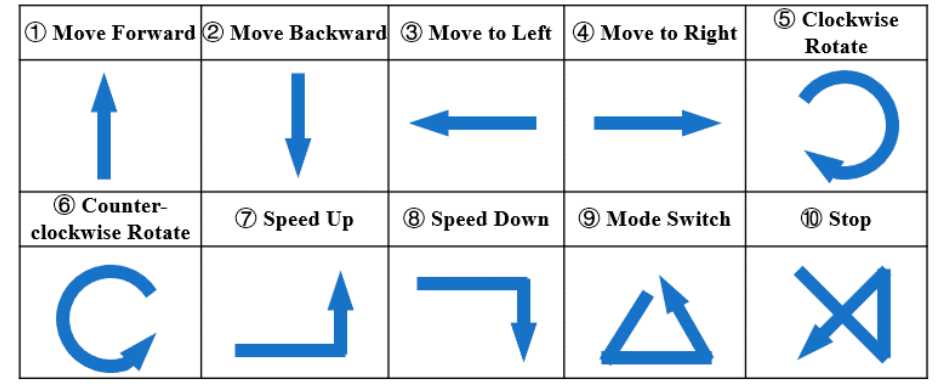
Figure 8. Ten predefined gestures for the interaction between human and nursing-care assistant robot.